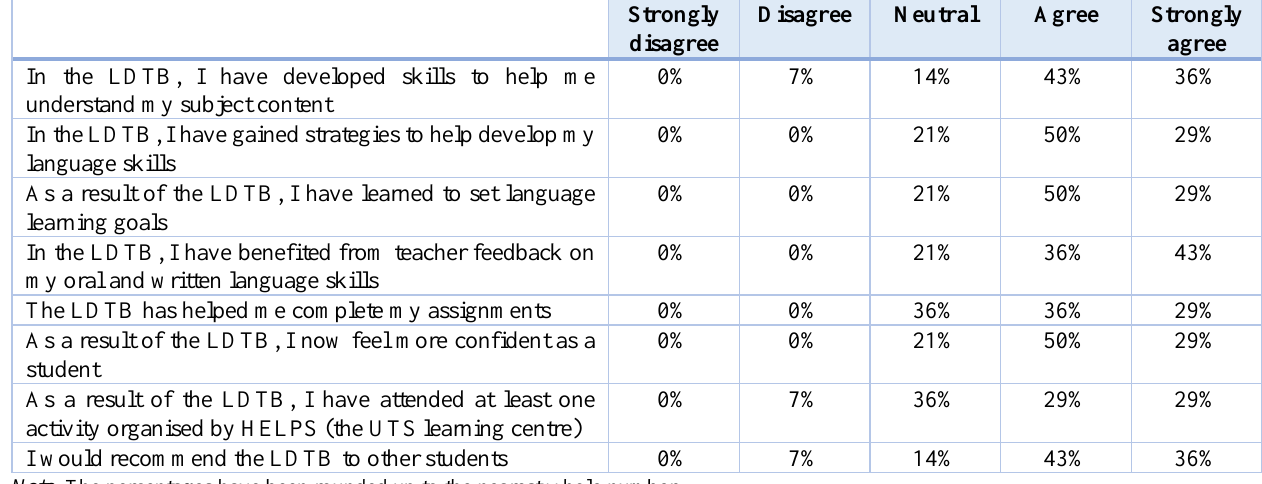
Strongly disagree